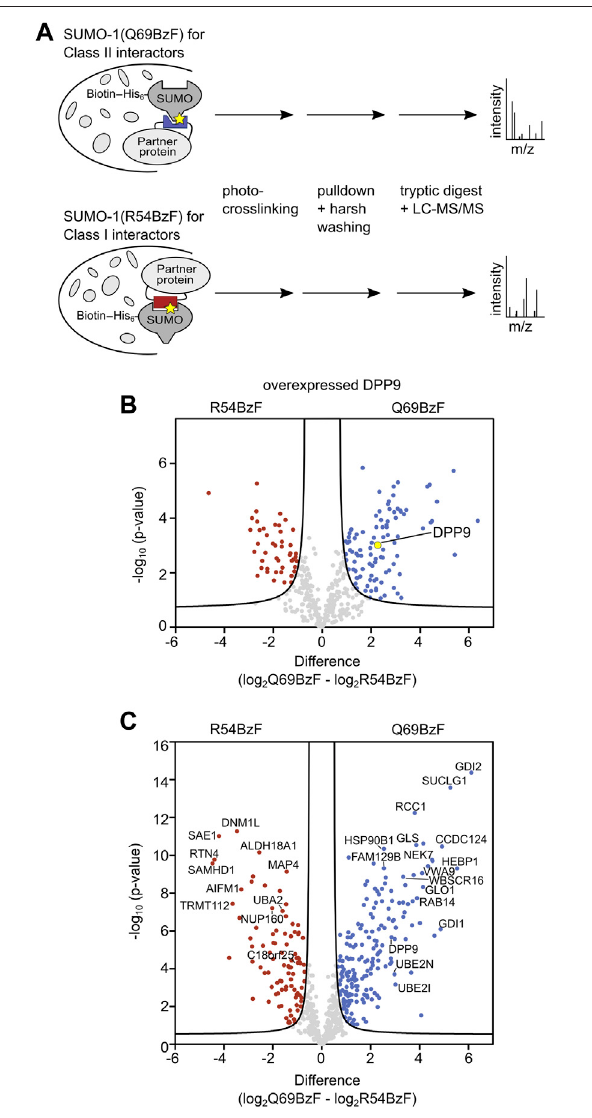
FIGURE 4 | Enrichment and identi fi cation of SUMO-1 binding partners. (A) Scheme of enrichment protocol. The respective SUMO-1 probe was mixed with whole-cell extracts and the sample was UV-irradiated. The crosslinked products were enriched by streptavidin beads and stringent washing with 8 M Urea was applied, followed by on-bead tryptic digest and LC-MS/MS analysis. Label-free quanti fi cation (LFQ) was performed. (B) VolcanoplotshowingDPP9beingsigni fi cantlyenrichedbySUMO-1(Q69BzF) compared to SUMO-1 (R54BzF). The respective SUMO-1 probe was incubated with HEK293T cell extract of cells transiently transfected with HA- DPP9 followed by crosslinking and enrichment as described in (A) . Student ’ s t-test (s0 = 0.5, FDR < 0.01, n = 3) was applied to determine signi fi cantly enriched proteins for each SUMO-1 probe, highlighted in red (R54BzF) and blue (Q69BzF). DPP9 is highlighted as yellow dot. (C) Volcano plot visualizing signi fi cantly enriched proteins by the two SUMO-1 probes after photo- crosslinking. Enrichment of SUMO-1 binders was performed at endogenous levels from whole-cell HeLa cell extracts. LC-MS/MS and LFQ analysis was performed, followed by Student ’ s t-test (s0 = 0.5, FDR < 0.01, n = 6). Signi fi cantly enriched proteins are highlighted in red (R54BzF) and blue